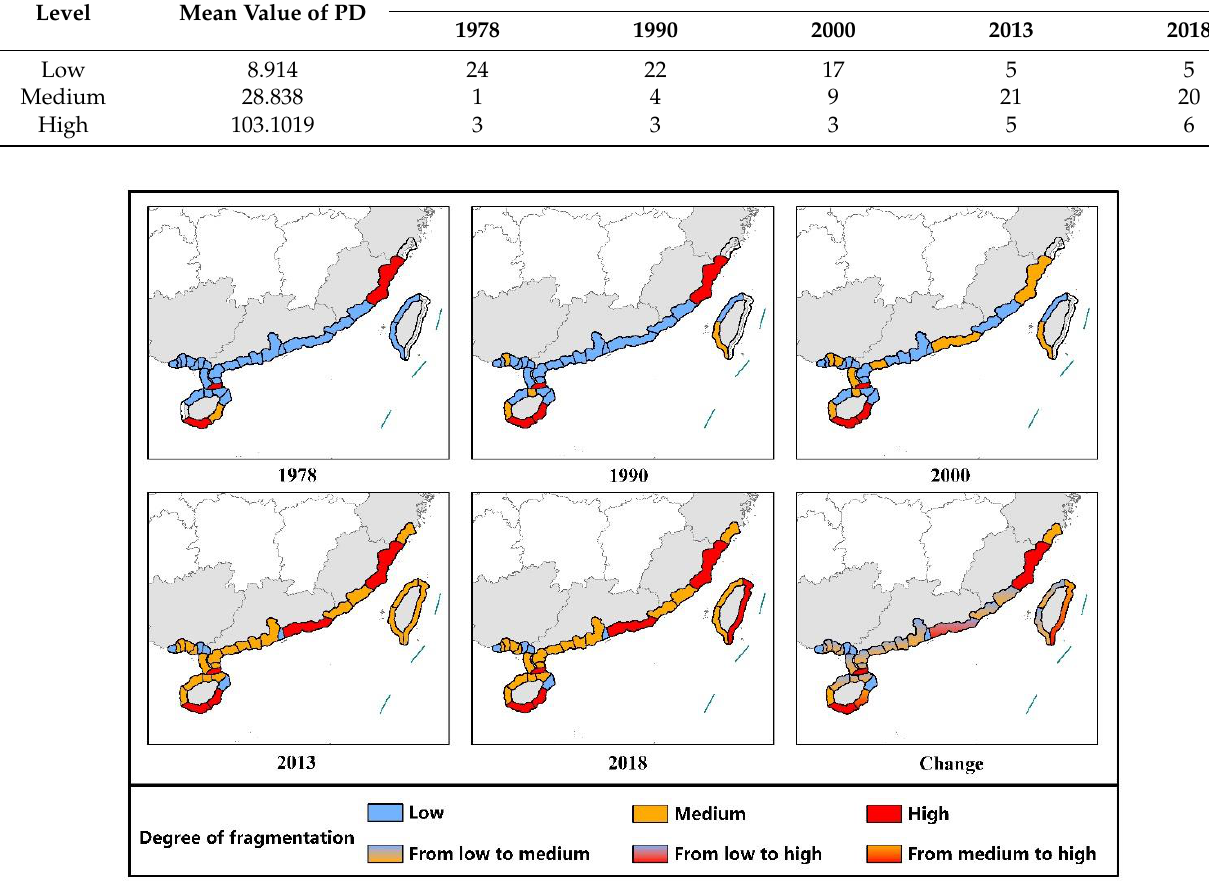
Figure 5. Temporal and spatial variations in the